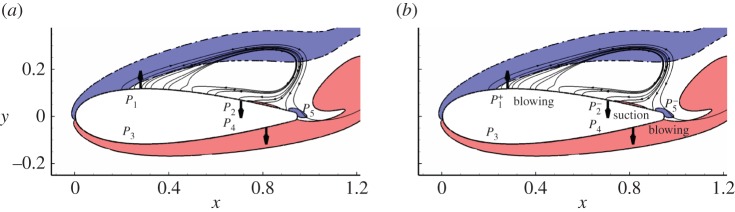
Schematic plots of (a) uncontrolled and (b) controlled flow. The control is scaled from the sensitivity to drag at Re=1000, α=10°, ω=0 and b=0.05. The arrows denote the direction of the control. P1, P2, P3, P4 and P5 represent the uncontrolled pressure at the upper leading edge, upper trailing edge, lower leading edge, lower trailing edge and base regions, respectively. Superscripts + and − represent an increase and decrease in the pressure owing to the boundary control, respectively. Solid and dashed lines are contour lines of spanwise vorticity −6 and 6, respectively. Thin lines with arrows are streamlines around the suction side. (Online version in colour.)